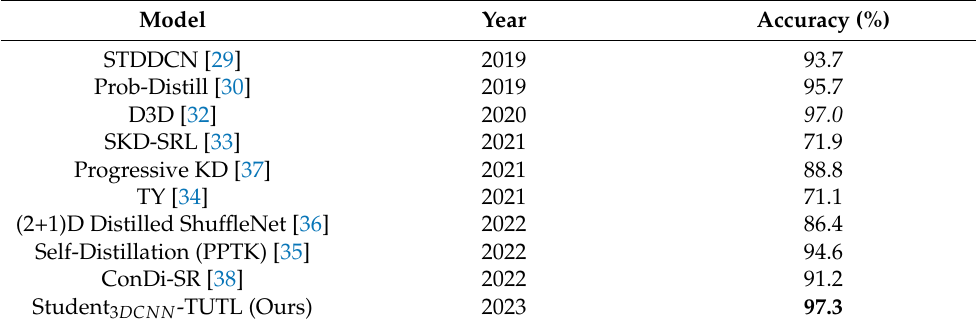
The best and runner-up accuracy scores are highlighted in bold and italic text, respectively. Table 13. Quantitative comparative analysis of our proposed method with the state-of-the-art knowledge distillation-based action recognition methods on UCF101 dataset.